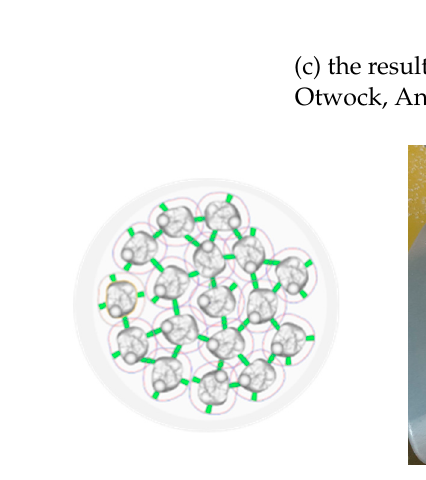
Figure 1. CAD/CAM preparation of zirconia crowns.